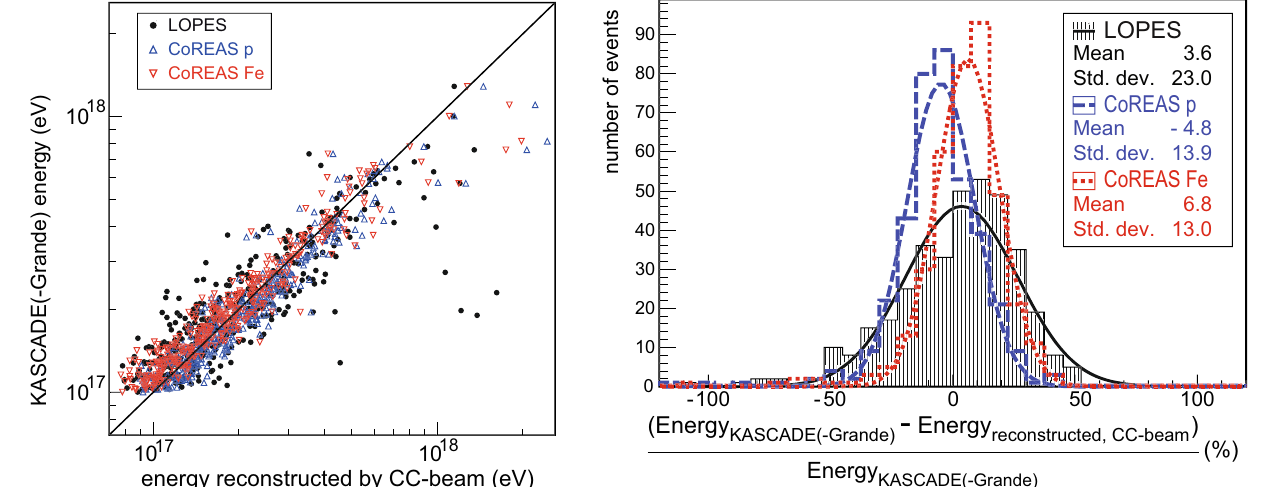
netic Lorentz vector of p EW ≤ 0 . 1; for two of them the corresponding LOPES points are at energies about three times higher than the plot- ted range; for the other outliers see the discussion related to Figs. 10 and 12 . Right: Histogram of the relative deviation, where the standard deviation provides a measure of the energy